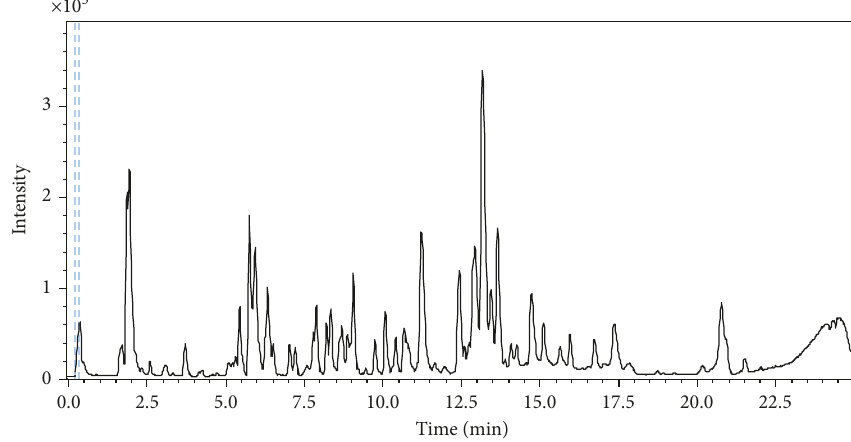
Figure 1: Base peak chromatogram of “Chemlali” olive leaf extract from Zaghouan